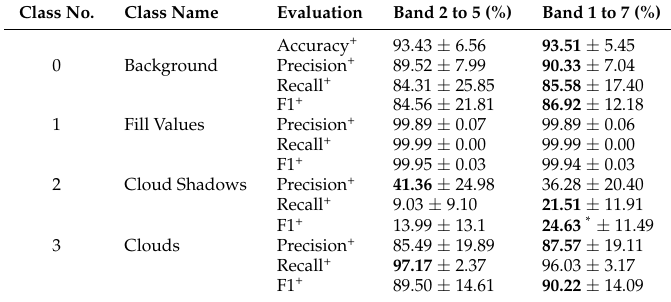
Table 5. Average scores of accuracy, precision, recall, and F1 in the comparison between four and seven-band models; * highlights the significant differences ( p -value < 0.05) in Wilcoxon signed-rank test. The top results are highlighted in